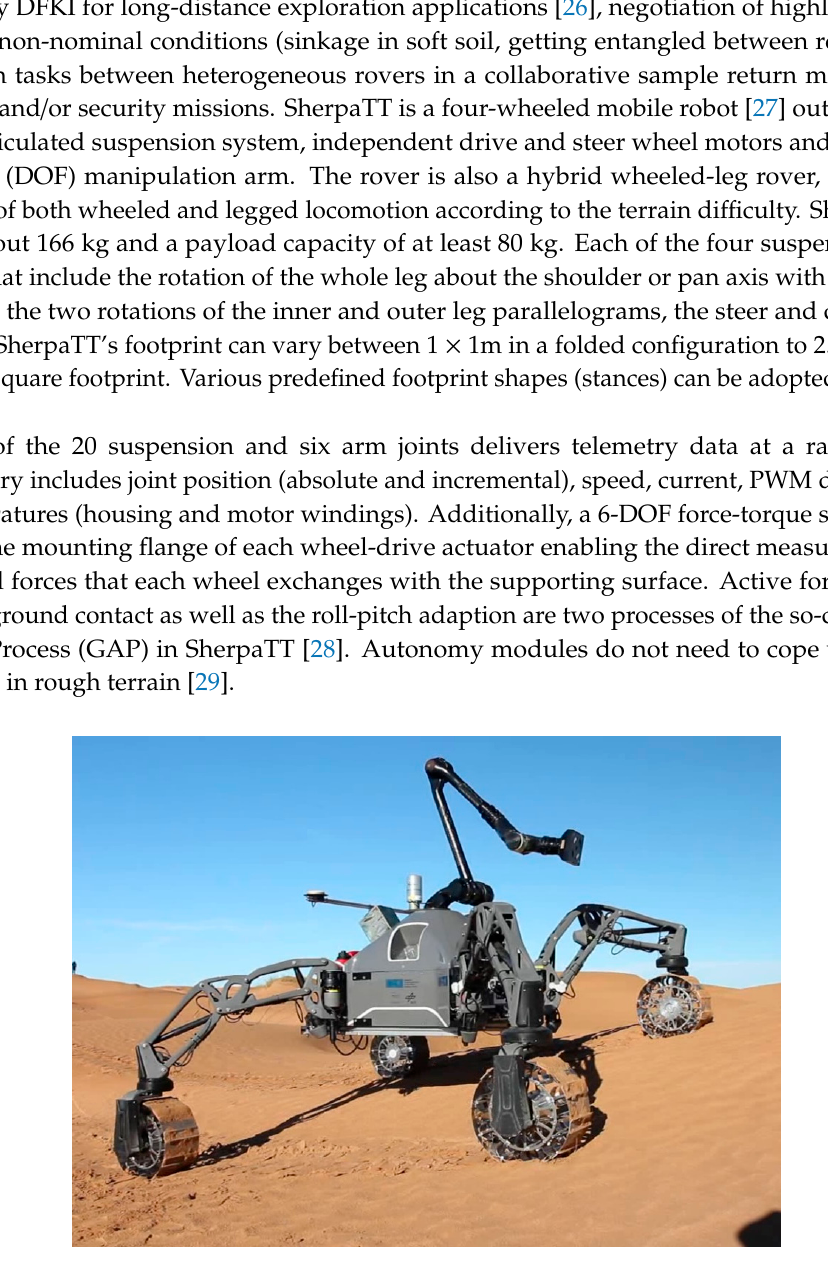
Figure 1. SherpaTT in soft sand dunes during Morocco field trials in 2018.